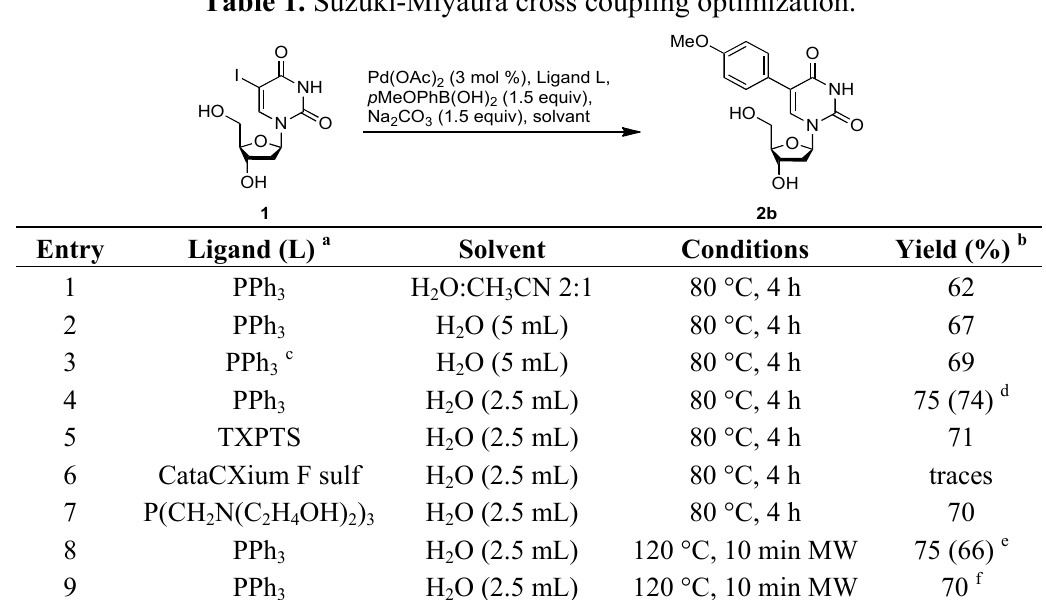
Table 1. Suzuki-Miyaura cross coupling